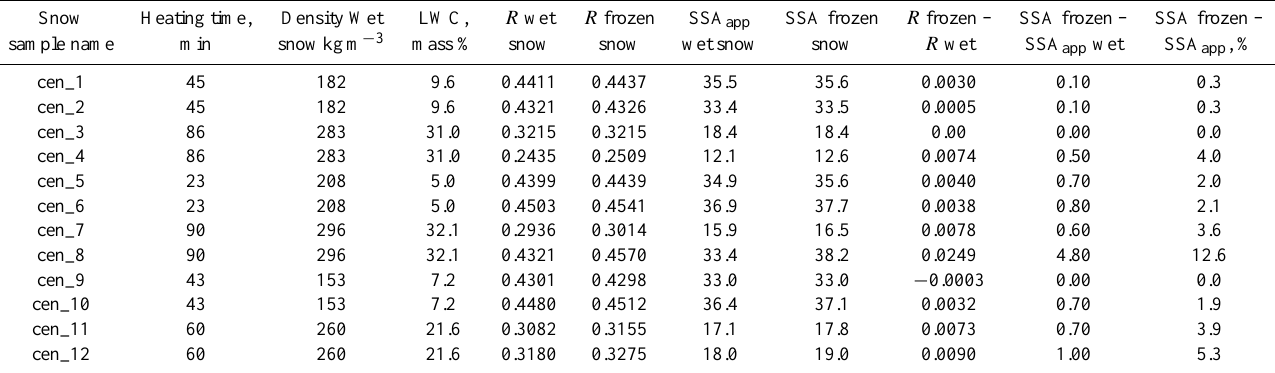
Table 1. Density, liquid water content (LWC), reflectance at 1310nm (R), and specific surface area (SSAm 2 kg − 1 ) of the samples studied, wet at 0 ◦ C and frozen. SSAs for wet samples are apparent values as defined in the text. Snow